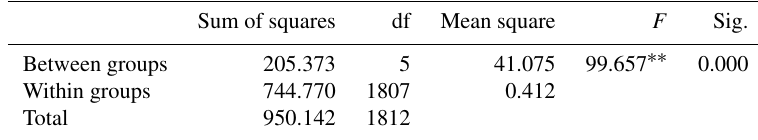
Table 3. Tables of analysis of the variance between degradation severity and different climate types.